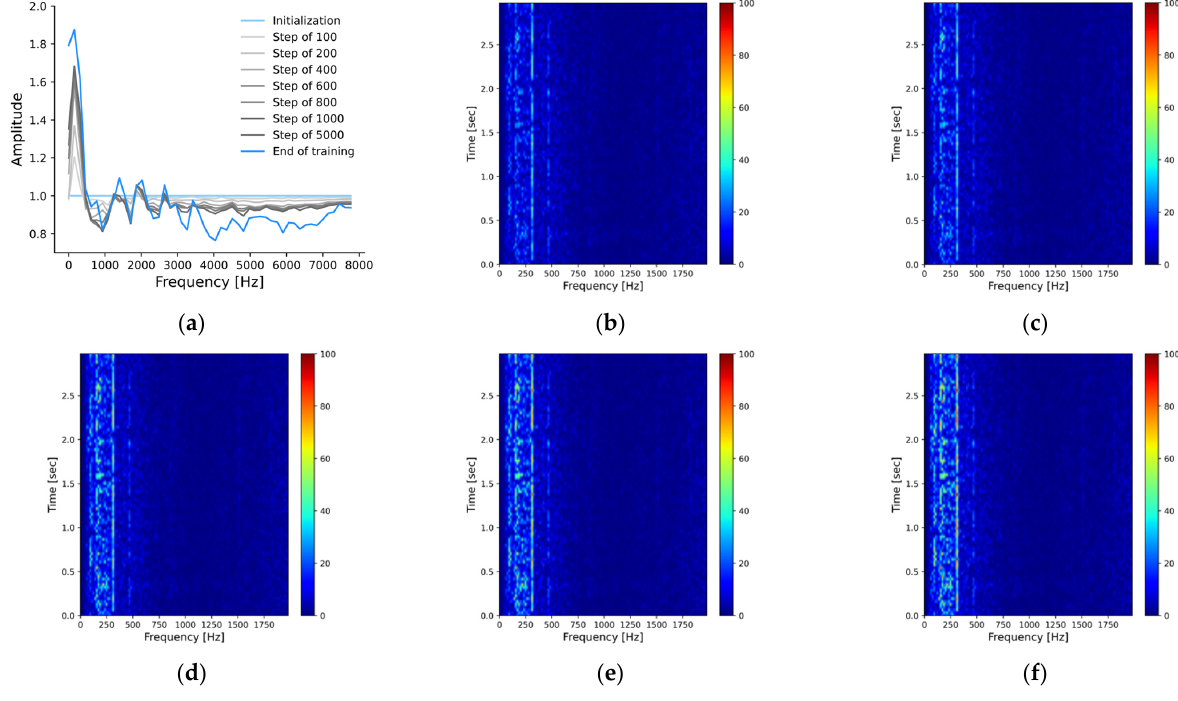
Figure 4. The frequency response of TFCK and spectrograms of a filtered signal at a specific frequency band in the pre-trained stage. ( a ) The frequency response of TFCK; ( b ) Initialization; ( c ) The step of 100; ( d ) The step of 400; ( e ) The step of 1000; ( f ) End of training.